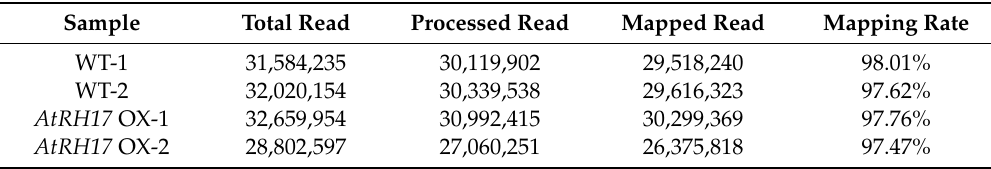
Table 1. Summary of mapping transcriptome reads to reference sequence.